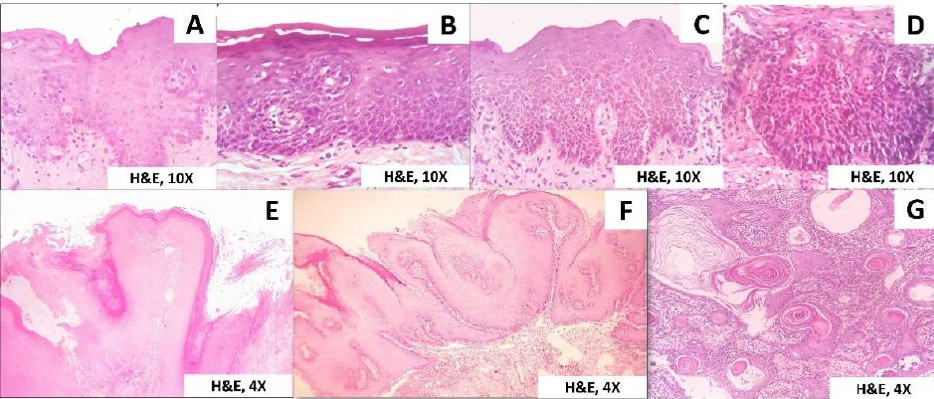
Figure 2. Histopathological spectrum of PVL. ( A ) Mild epithelial dysplasia, ( B ) Moderate epithe- lial dysplasia, ( C ) Severe epithelial dysplasia, ( D ) Carcinomas in situ, ( E ) Verrucous hyperplasia, ( F ) Verrucous carcinoma, ( G ) Squamous cell carcinoma.